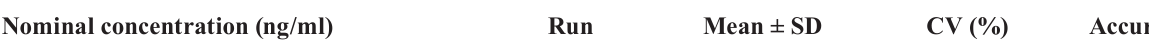
Nominal concentration